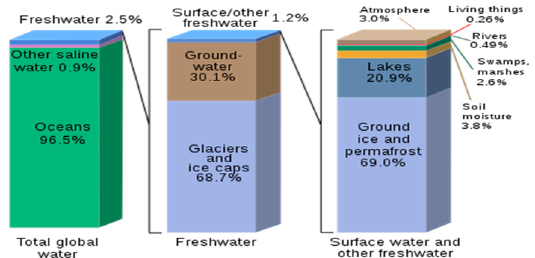
Figure 5. Locations of H 2 O on earth (Source: Wikipedia, 2021) [26].